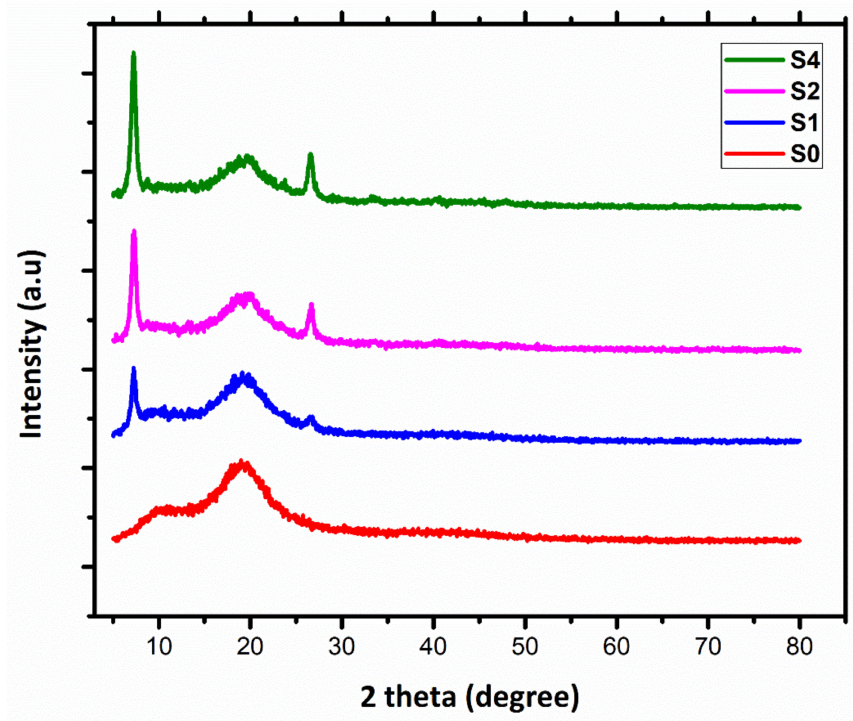
Figure 4. XRD patterns of pristine PS (S0) and PS/m-sepiolite nanocomposites S1, S2 and S4